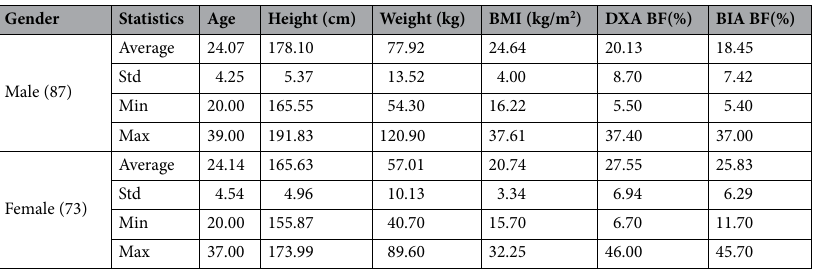
Table 1. Collected data